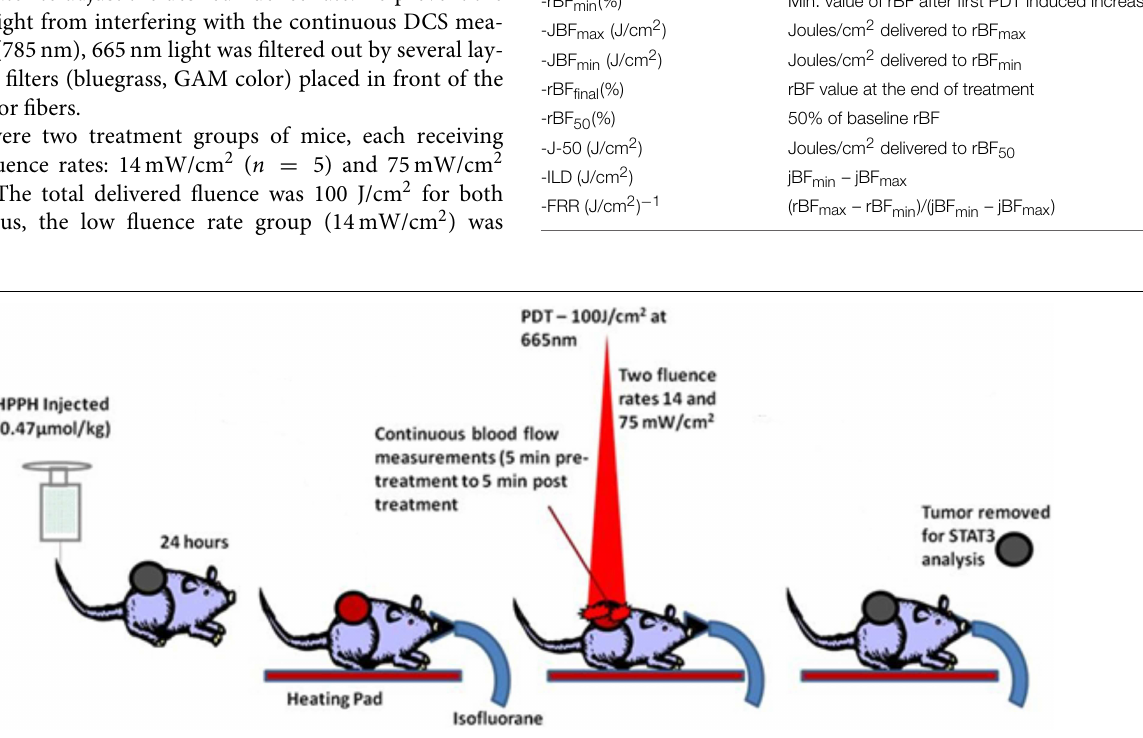
Frontiers in Physics |